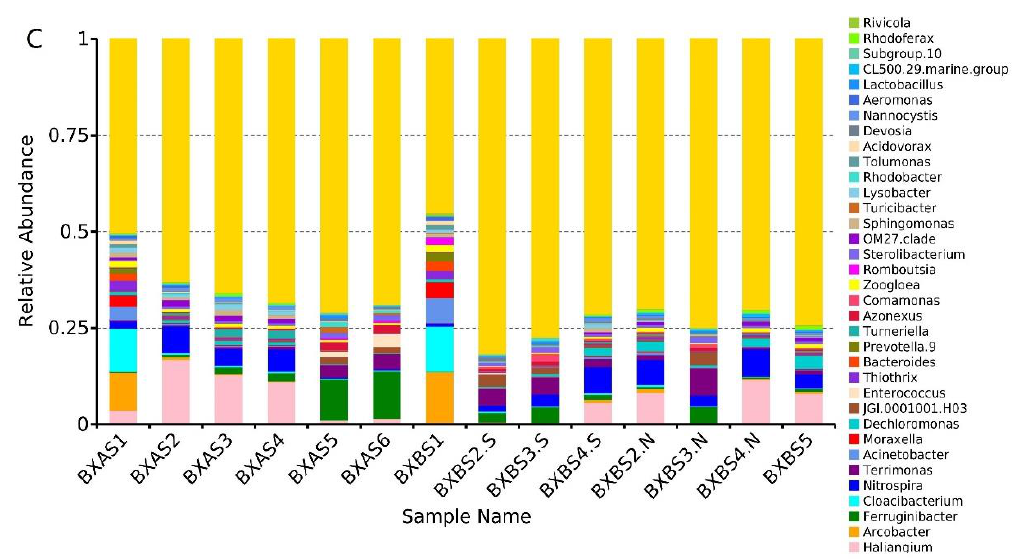
Figure 2. Histogram of the relative abundance of bacterial phyla—( A ) top 15 species at the phylum level; ( B ) top 15 species at the family level; and ( C ) top 15 species at the genus level.